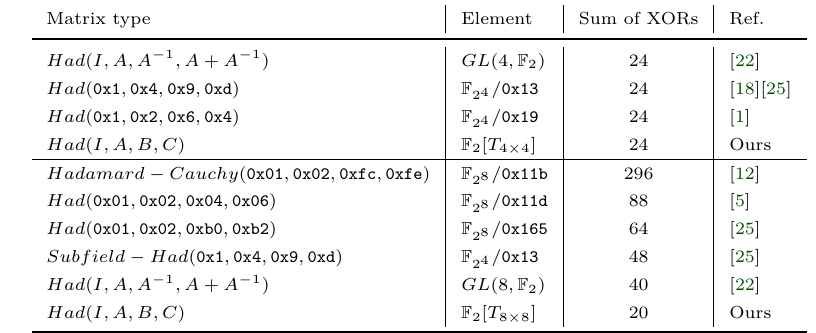
Table 5: Comparisons with previous constructions of lightweight involutory Hadamard MDS matrices